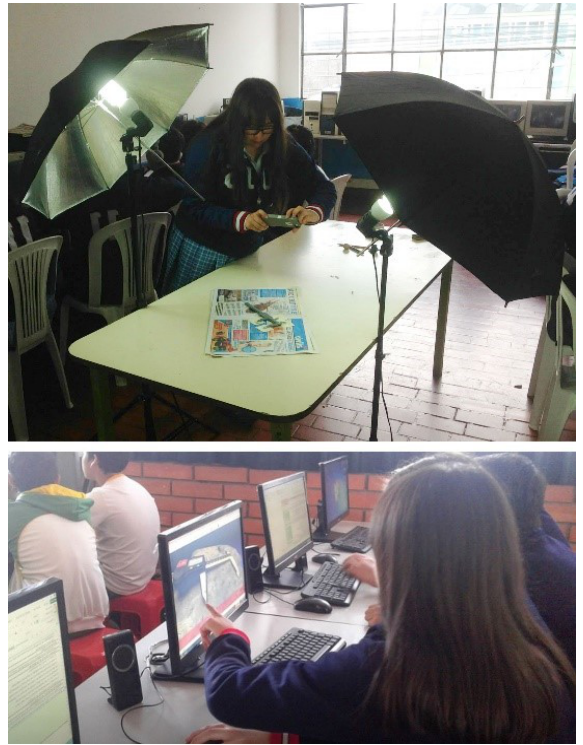
Figure 7. Students learning strategies to measure with